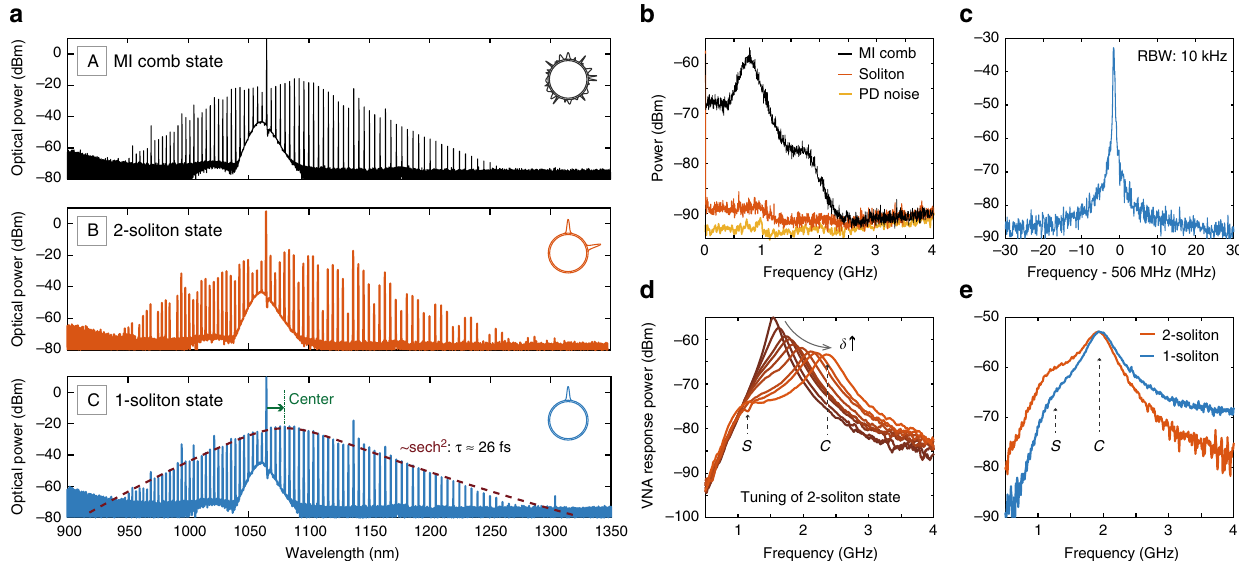
Fig. 2 Dissipative Kerr solitons at 1 μ m and their characterisation. a Optical spectra of the modulation-instability (MI) comb state (A) and two soliton states (B and C) obtained in a 1-THz Si 3 N 4 microresonator (pump is located at around 1065 nm). The transition from two-soliton state (B) to single-soliton state (C) was obtained by backward tuning technique of the pump laser. Insets show the estimated positions of the DKS in corresponding states. The single- soliton state was fi tted with the sech 2 envelope (dashed dark blue) for an estimated duration of 26 fs. The green arrow shows the Raman-induced red spectral shift of the soliton spectrum with respect to the pump line. b Intensity noise of MI comb state (black), soliton states (red) shown in Fig. 1 a and the noise fl oor of the photodiode (PD) used for measurements (yellow). c Heterodyne beatnote of the soliton comb line around 1050 nm with a second CW laser. d System response evolution in the two-soliton state shown in a , when increasing the pump-cavity detuning ( δ ). The positions of characteristic C -resonance and S -resonance are indicated with C and S letters correspondingly. e System response evolution when the DKS state is switched from two- soliton to single-soliton state. The amplitude of the S -resonance has decreased, because the number of intracavity solitons is